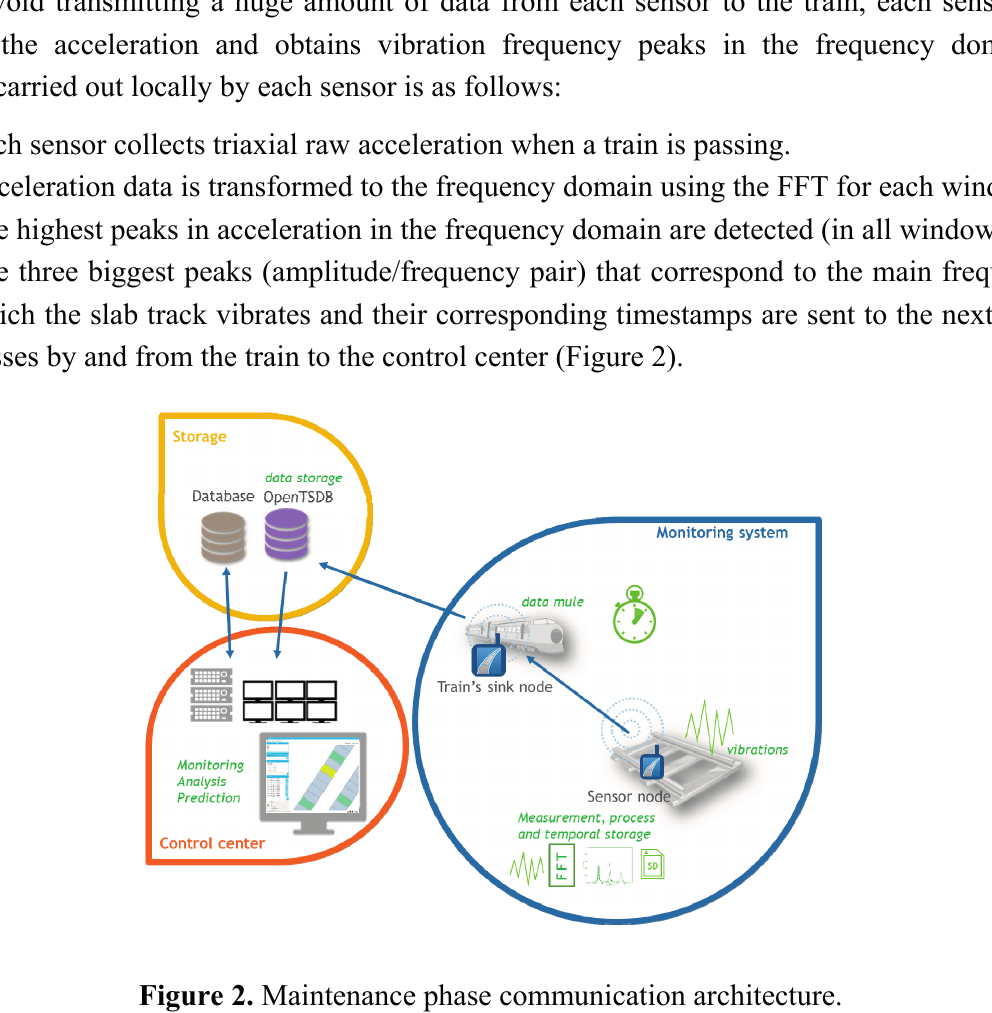
Figure 2. Maintenance phase communication